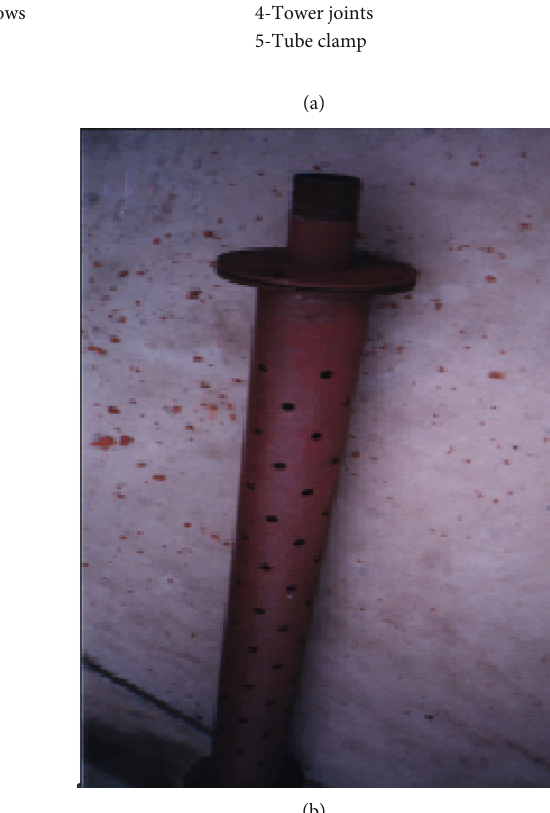
Figure 9: (a) The structure of drainage pipes for internal drainage and (b) the equipment of external